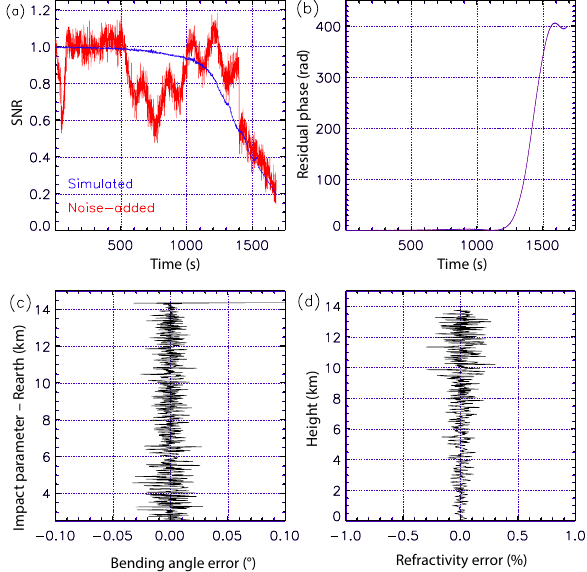
Figure 4. (a) The amplitude of the received signal simulated by the ray-tracing model (blue) and the noise-added amplitude (red), (b) residual phase with (red) and without (blue) the amplitude noise. Note that the residual phases with and without the amplitude noise are close to each other and appear to be on top of each other in the figure. (c) FSI-retrieved bending angle error, (d) fractional refrac- tivity error. The radius of the Earth has been subtracted from the impact parameter in (c) , where the Earth’s surface is at ∼